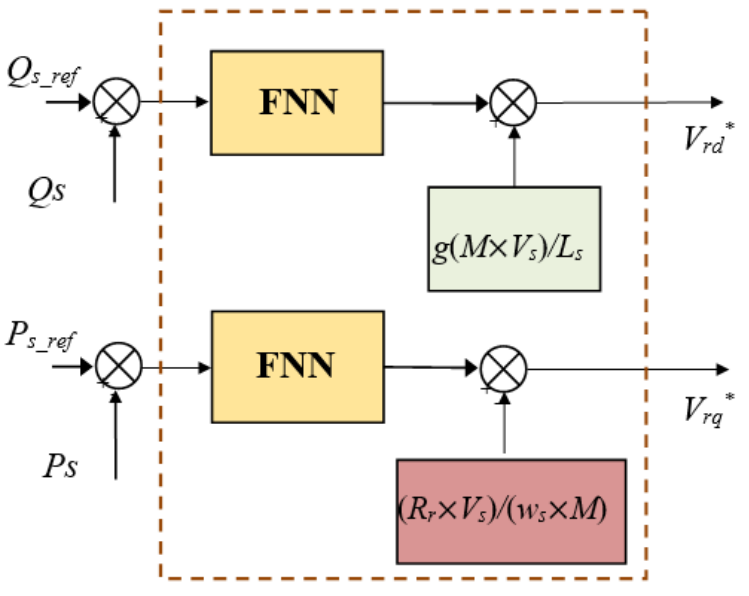
Figure 11. Structure of the DVC-FNN method.